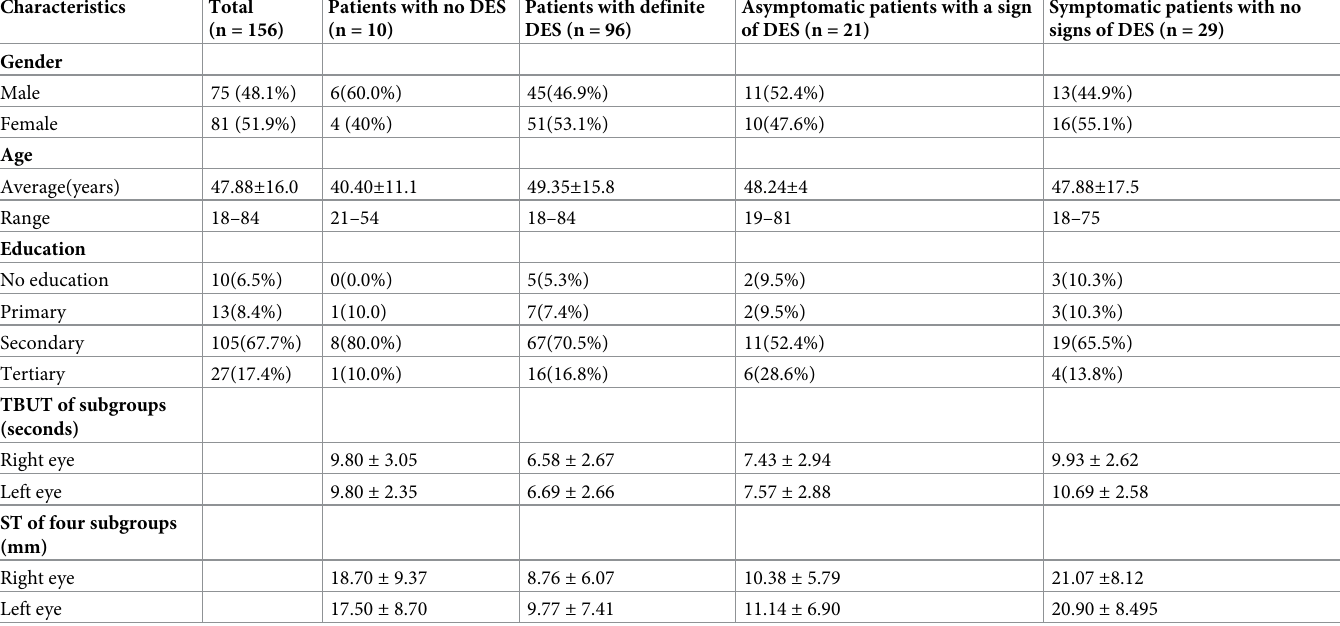
Table 2. Group characteristics of